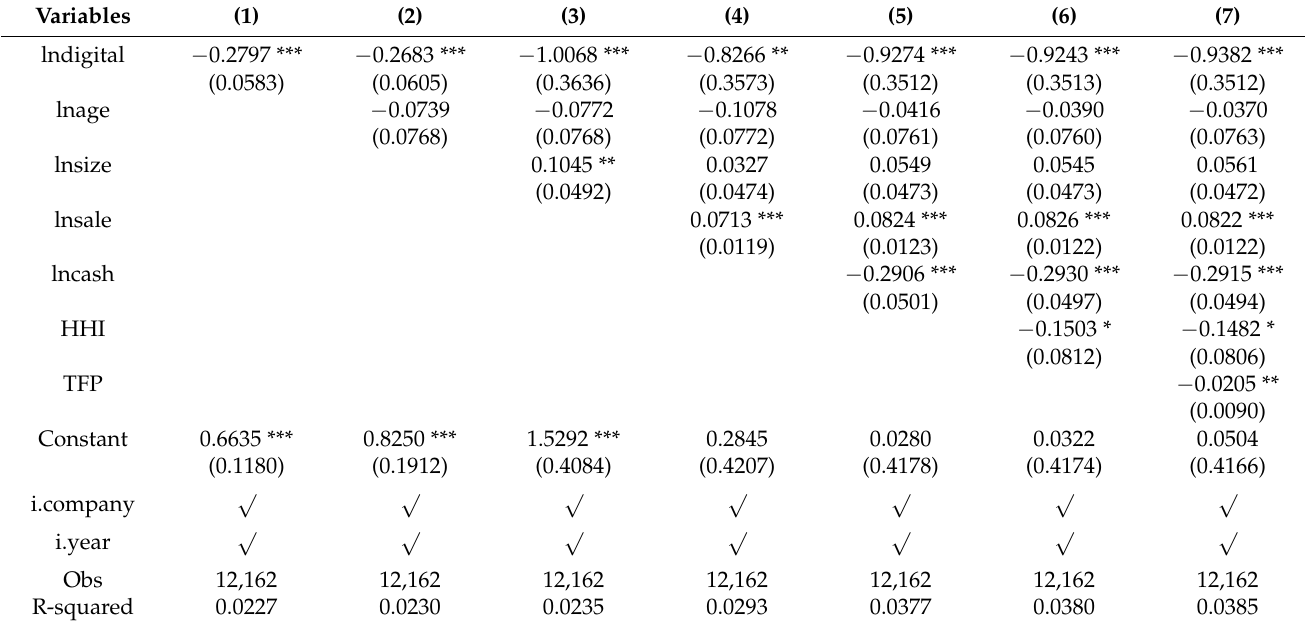
Table 3. Baseline estimation